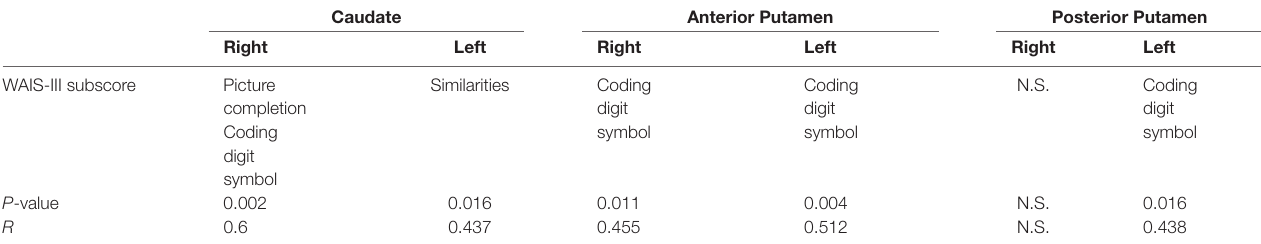
TABLE 2 | The multiple regression analyses of Wechsler Adult Intelligence Scale—Third Edition (WAIS-III) subscores and six subregions of striatal dopamine transporter (DAT) binding. Caudate